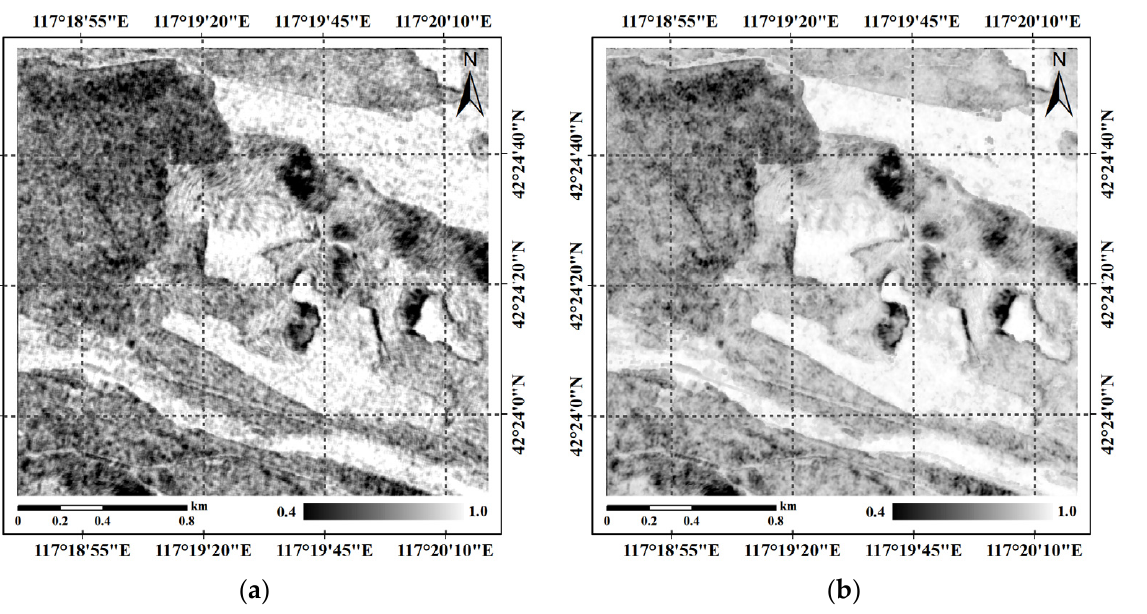
Figure 12. Histogram of the coherence images.